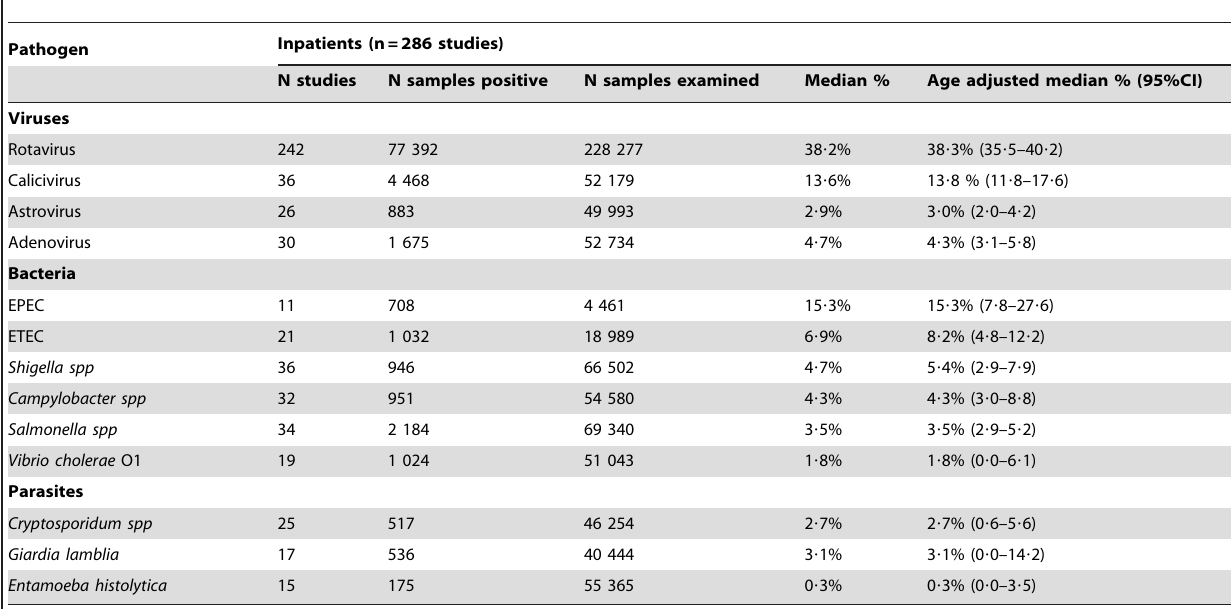
Table 1. Age-adjusted median proportions of diarrheal episodes requiring hospitalizations associated with each enteropathogen in children 0–59 m of age in the